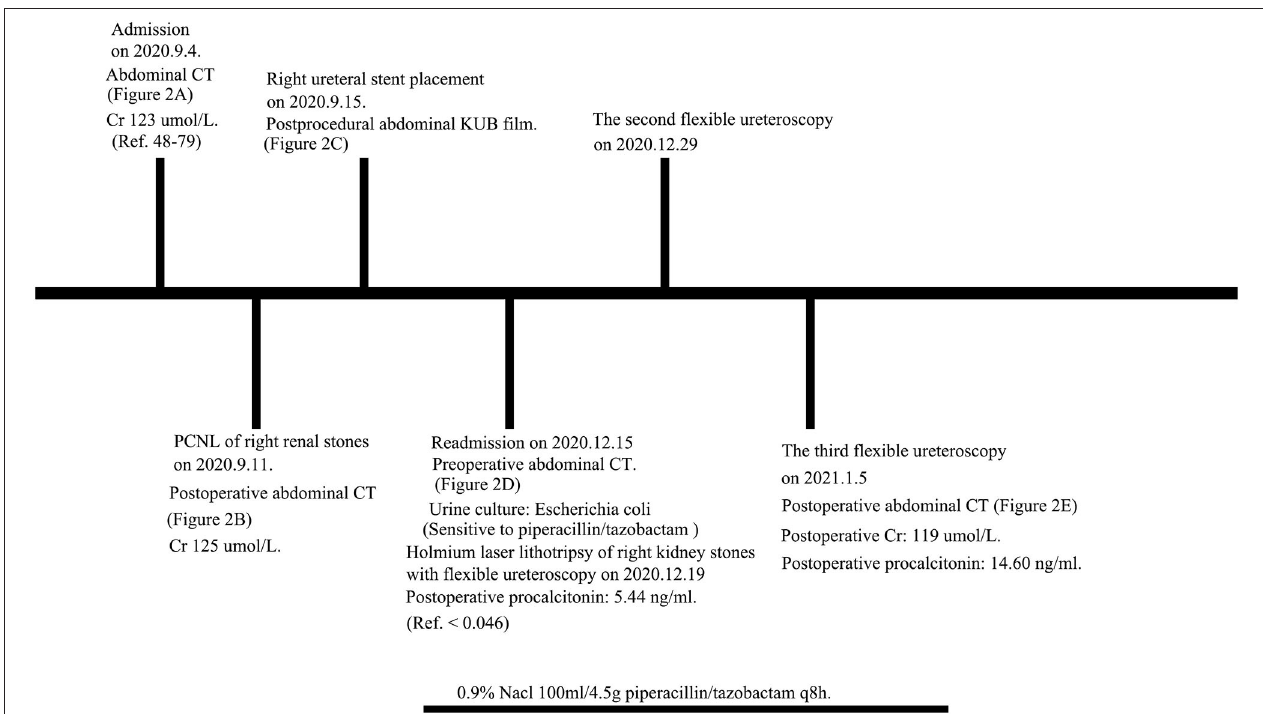
FIGURE 2 | The timeline picture of this case. Cr, creatinine; PCNL, percutaneous nephrolithotomy; Ref., reference.